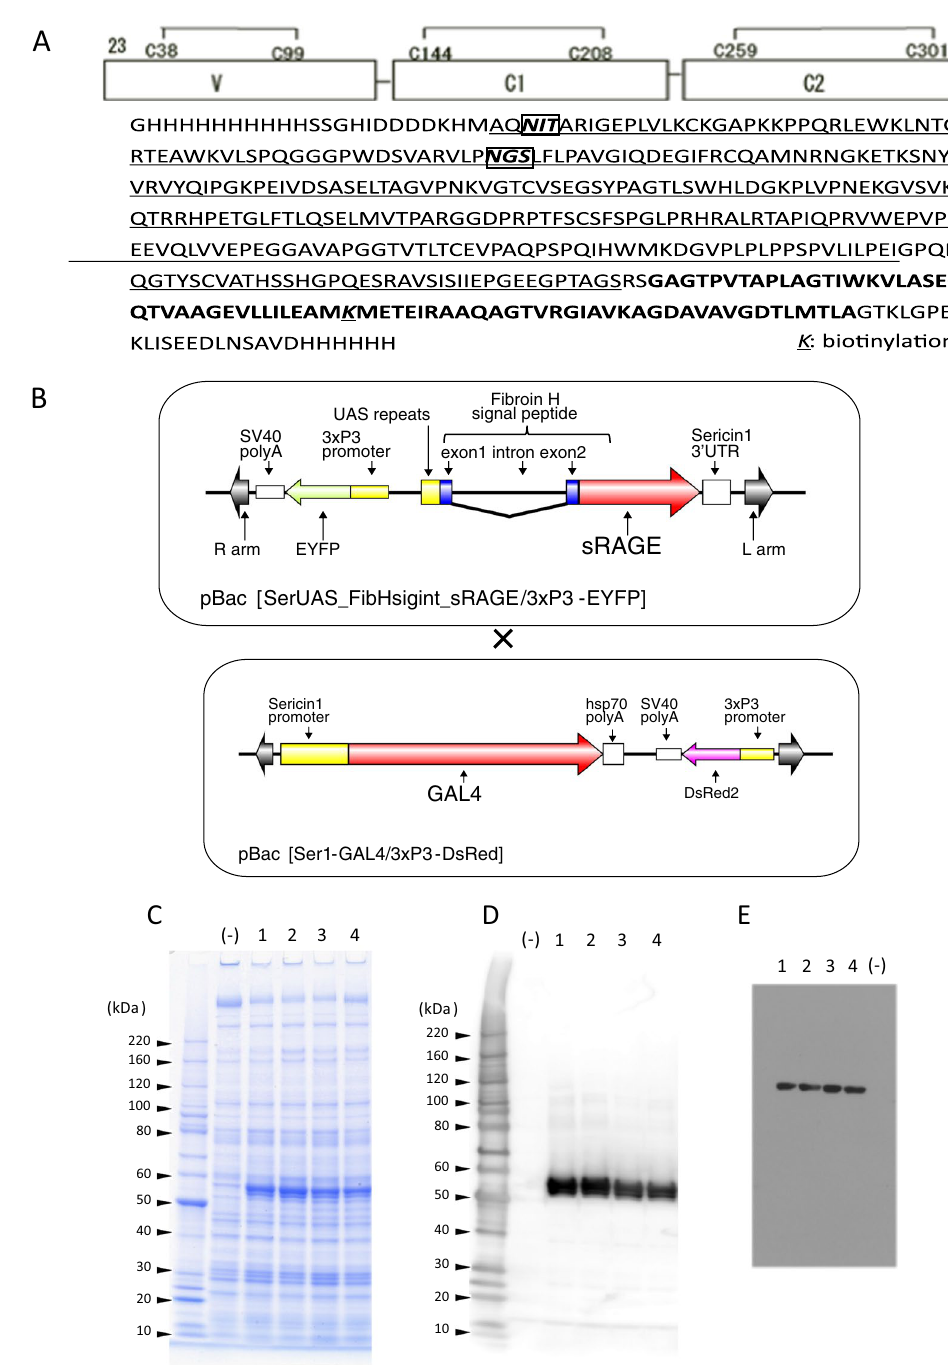
Figure 1. Expression of sRAGE in MSGs of transgenic silkworms. ( A ) Upper panel: Schematic diagrams of the domain structure of the extracellular domain of human RAGE. Numbers correspond to the amino acid (aa) sequence of full-length hRAGE, a 404-amino acid protein composed of an extracellular domain (aa 23–332). C represents cysteine residues involved in S-S linkages. Lower panel: Amino acid sequence of sRAGE expressed in this study. Underlined amino acids represent the RAGE region; bold indicates the BioEase tag; and boxes represent the potential N -glycosylation sites. ( B ) Generation of transgenic silkworms expressing the sRAGE gene. Adults transgenic silkworms harboring the sRAGE gene or GAL4 gene were mated. The MSGs were isolated from F1 larvae, and total proteins were extracted. ( C ) CBB staining of SDS-PAGE. The protein lysates extracted from MSGs were separated by SDS-PAGE followed by staining with CBB. ( D ) Detection with anti-His-tag antibodies. Lysates were separated with SDS-PAGE, followed by western blotting with anti-His-tag antibodies. The protein lysates extracted from MSGs of transgenic silkworms harboring only the Ser1-GAL4 construct were used as negative controls ( − ). ( E ) Detection with anti-RAGE antibodies. The numbers above the gel or blots indicate the line number of the transgenic strain. Numbers on the left indicate the molecular mass